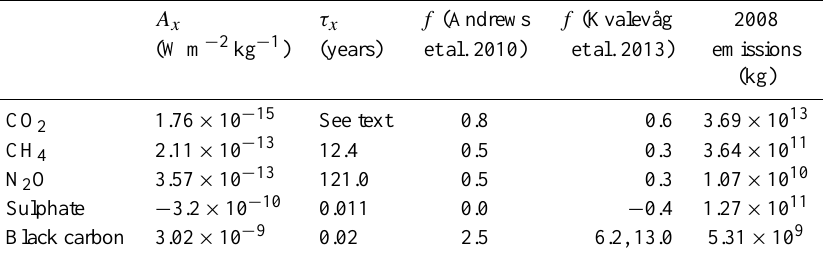
Table A1. Parameter values used for each species included in calculations. All values are taken from Myhre et al. (2013), unless otherwise stated, and the CH 4 and N 2 O values of A x include the indirect effects described